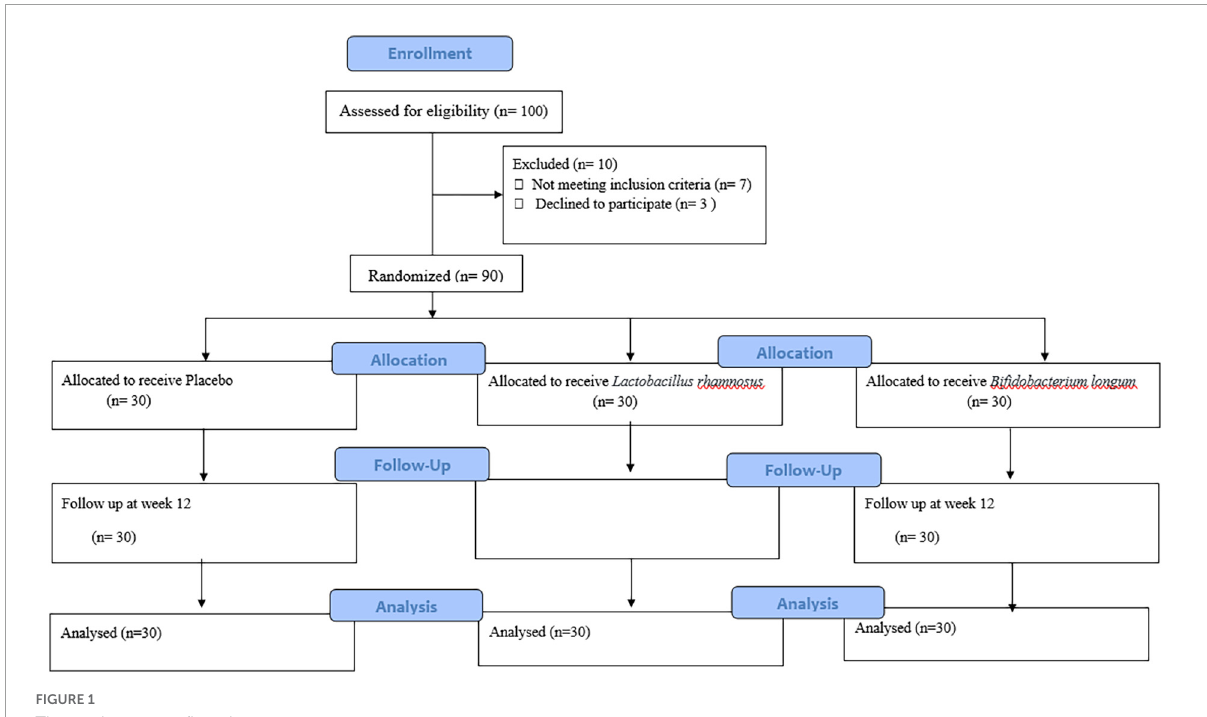
FIGURE1 The study consort